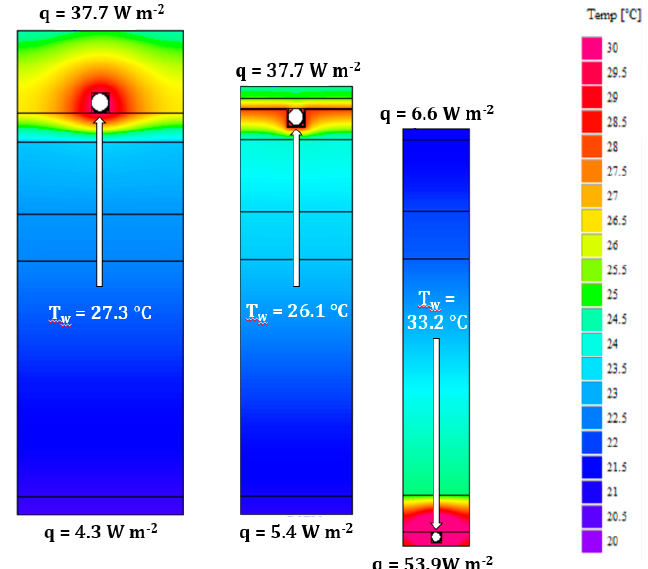
Figure 5. Example of calculation of the mean value of the water temperature required to fulfil the design heating load of the non-insulated building (3770 W) with the three different types of radiant systems. Average temperatures of the active surfaces are 23.4 °C in the floor heating cases and 28.3 °C in the case of radiant ceiling.